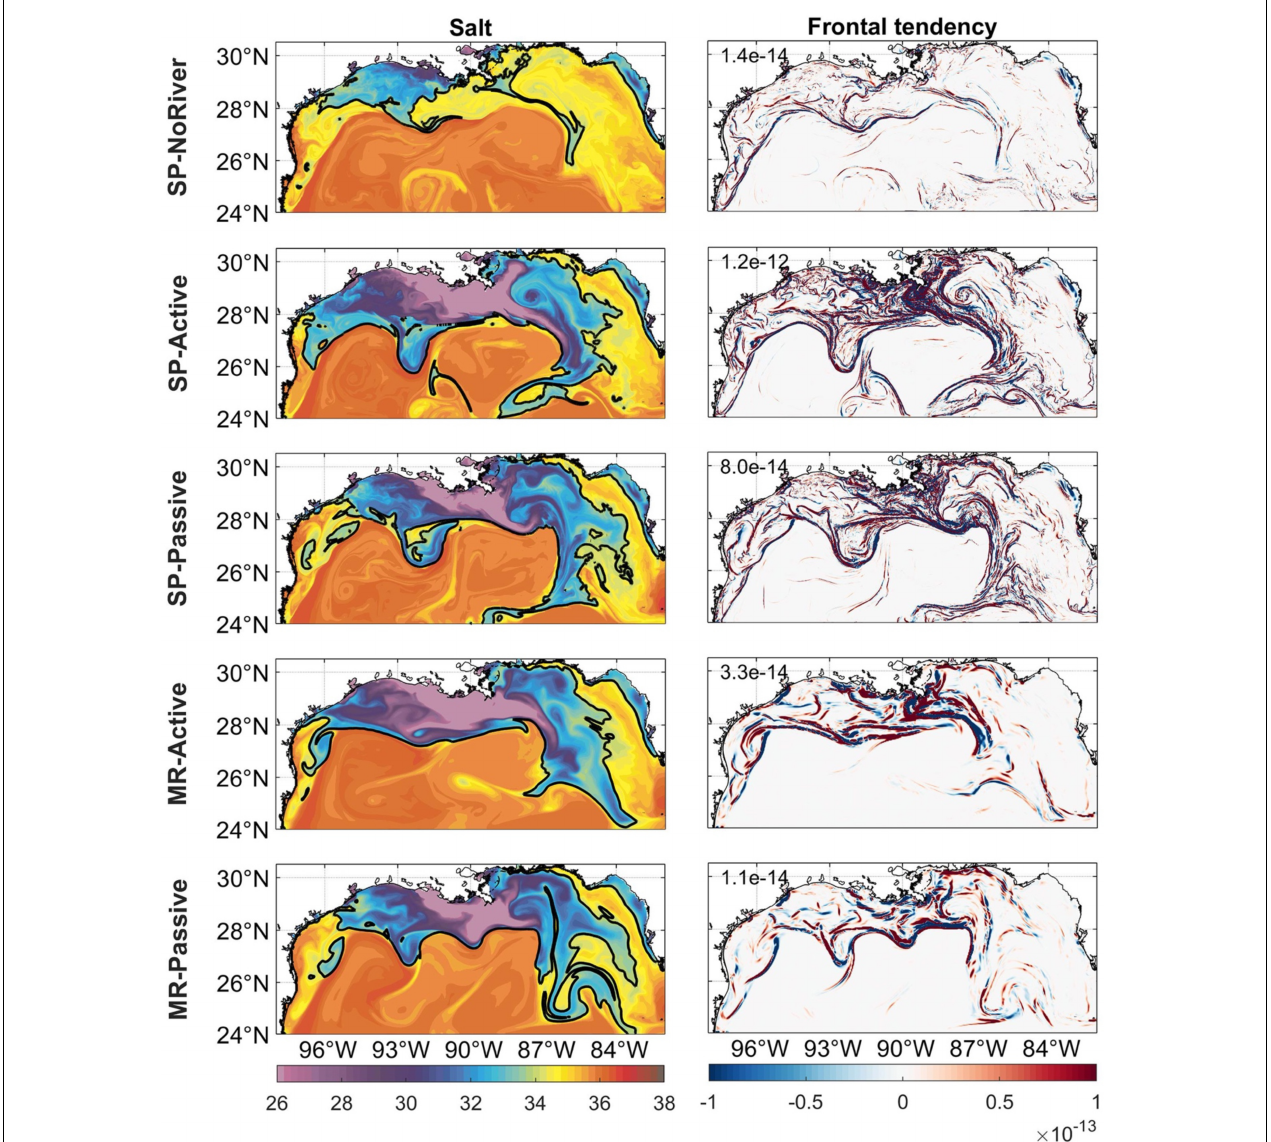
FIGURE 6 | Instantaneous surface salinity and frontal tendency on August 05, 2015 in the first member of each of the 5 ensembles 5 months after initialization. Domain-averaged values for F are indicated in each plot. Black contours in salinity fields indicate 34